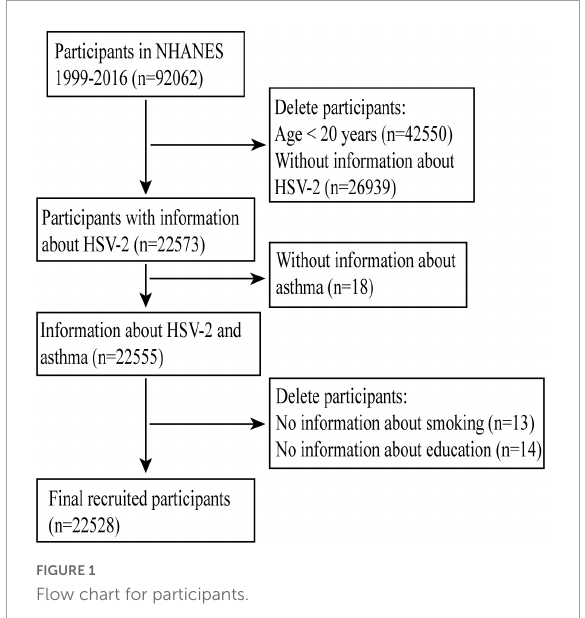
FIGURE1 Flow chart for